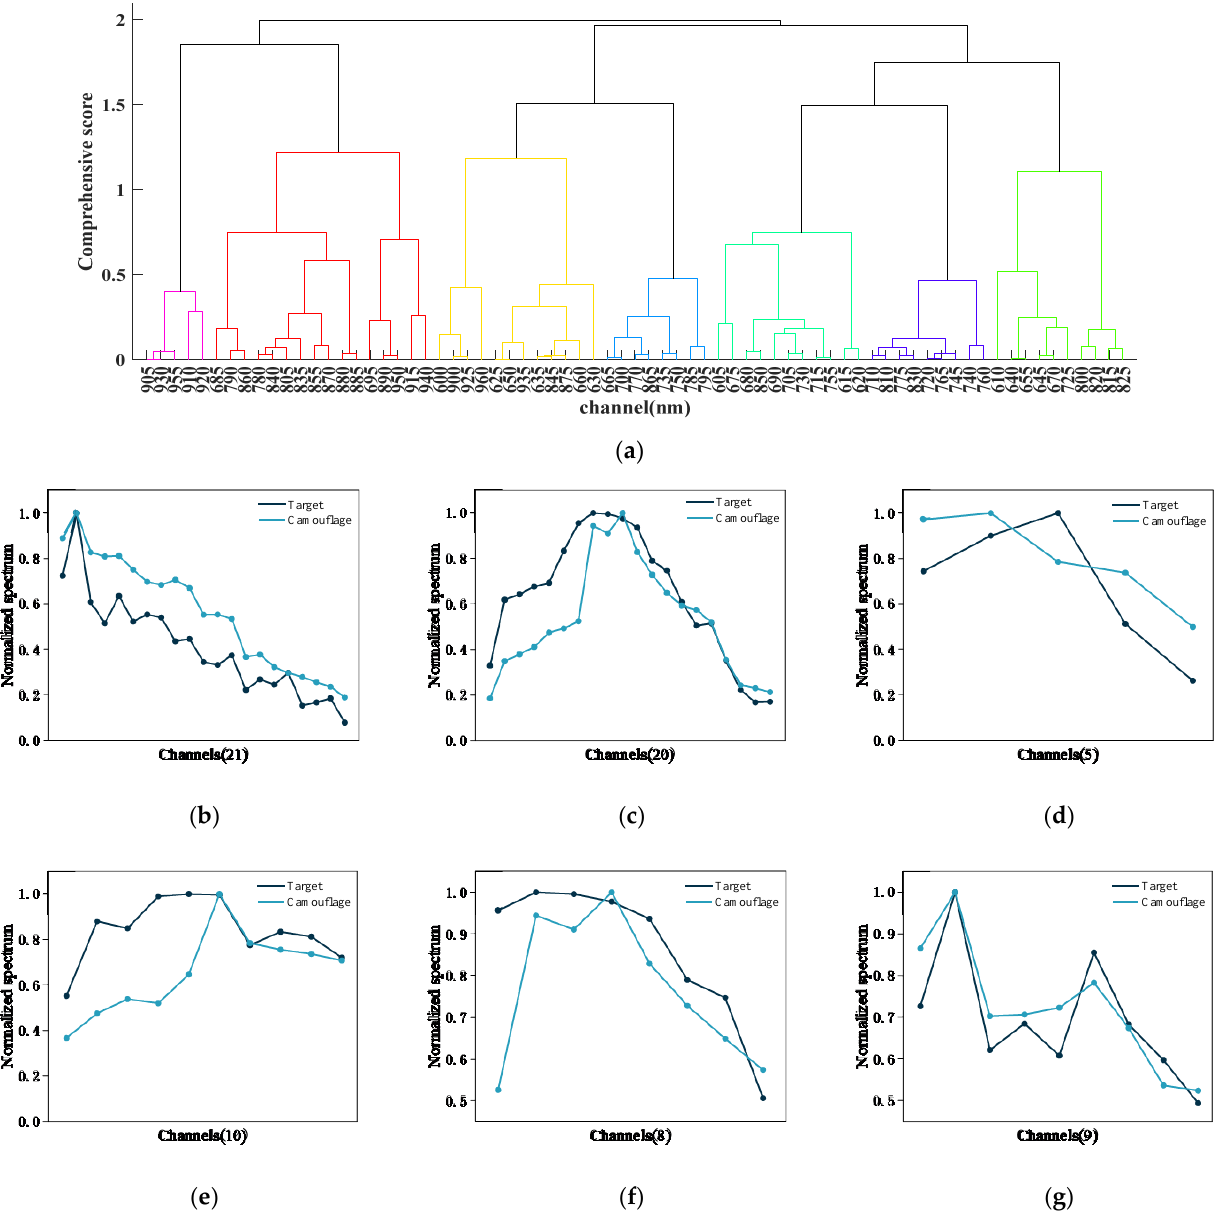
Figure 11. ( a ) Pedigree diagram obtained by clustering all channels and categories. ( b – g ) Result of classifying channels into categories.